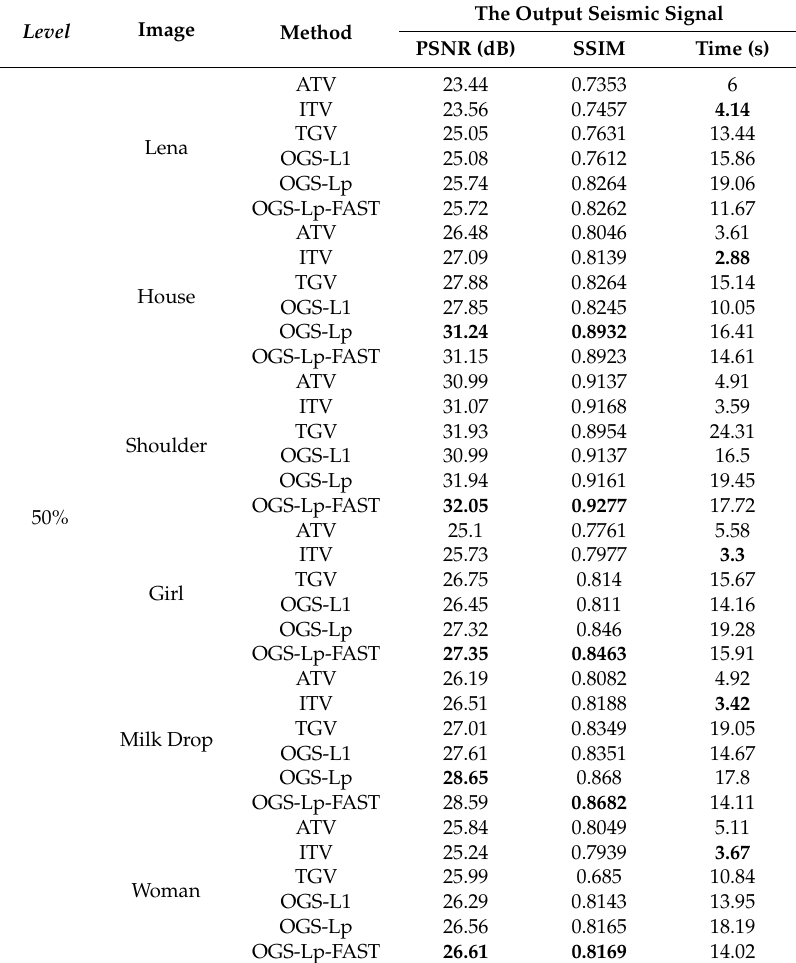
Table 5. Numerical comparison of our proposed method and other models (images are corrupted by impulse noise of